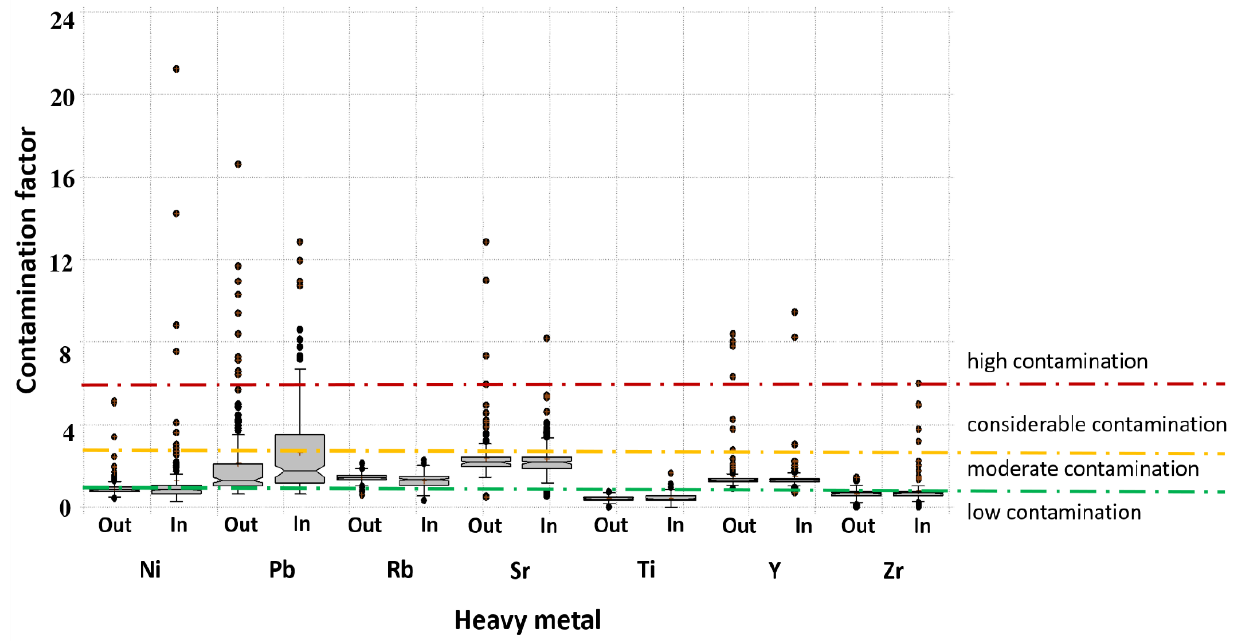
Figure 4. Boxplots for heavy metal contamination factors using the global background value for soils [25].